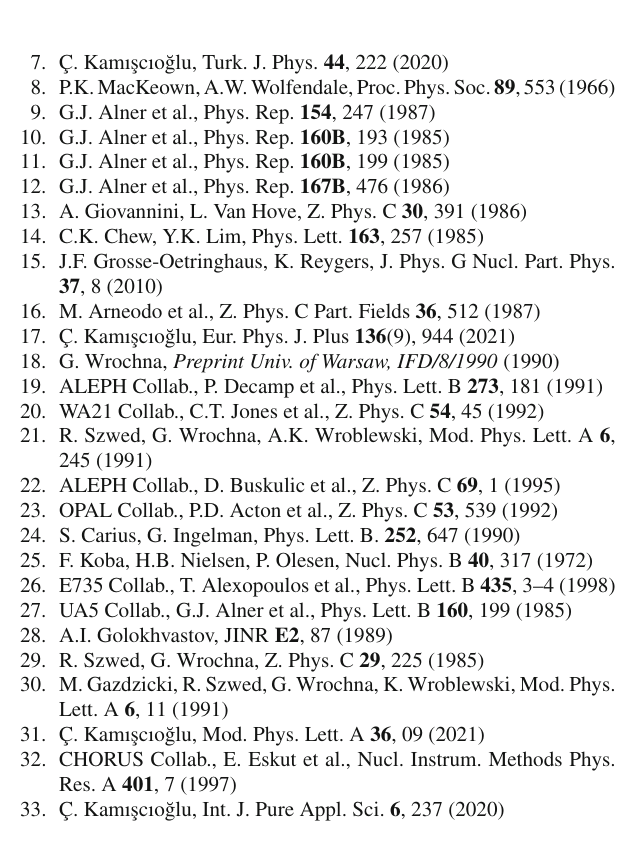
Table 3 Values of the parameters obtained in neutrino and anti-neutrino interactions